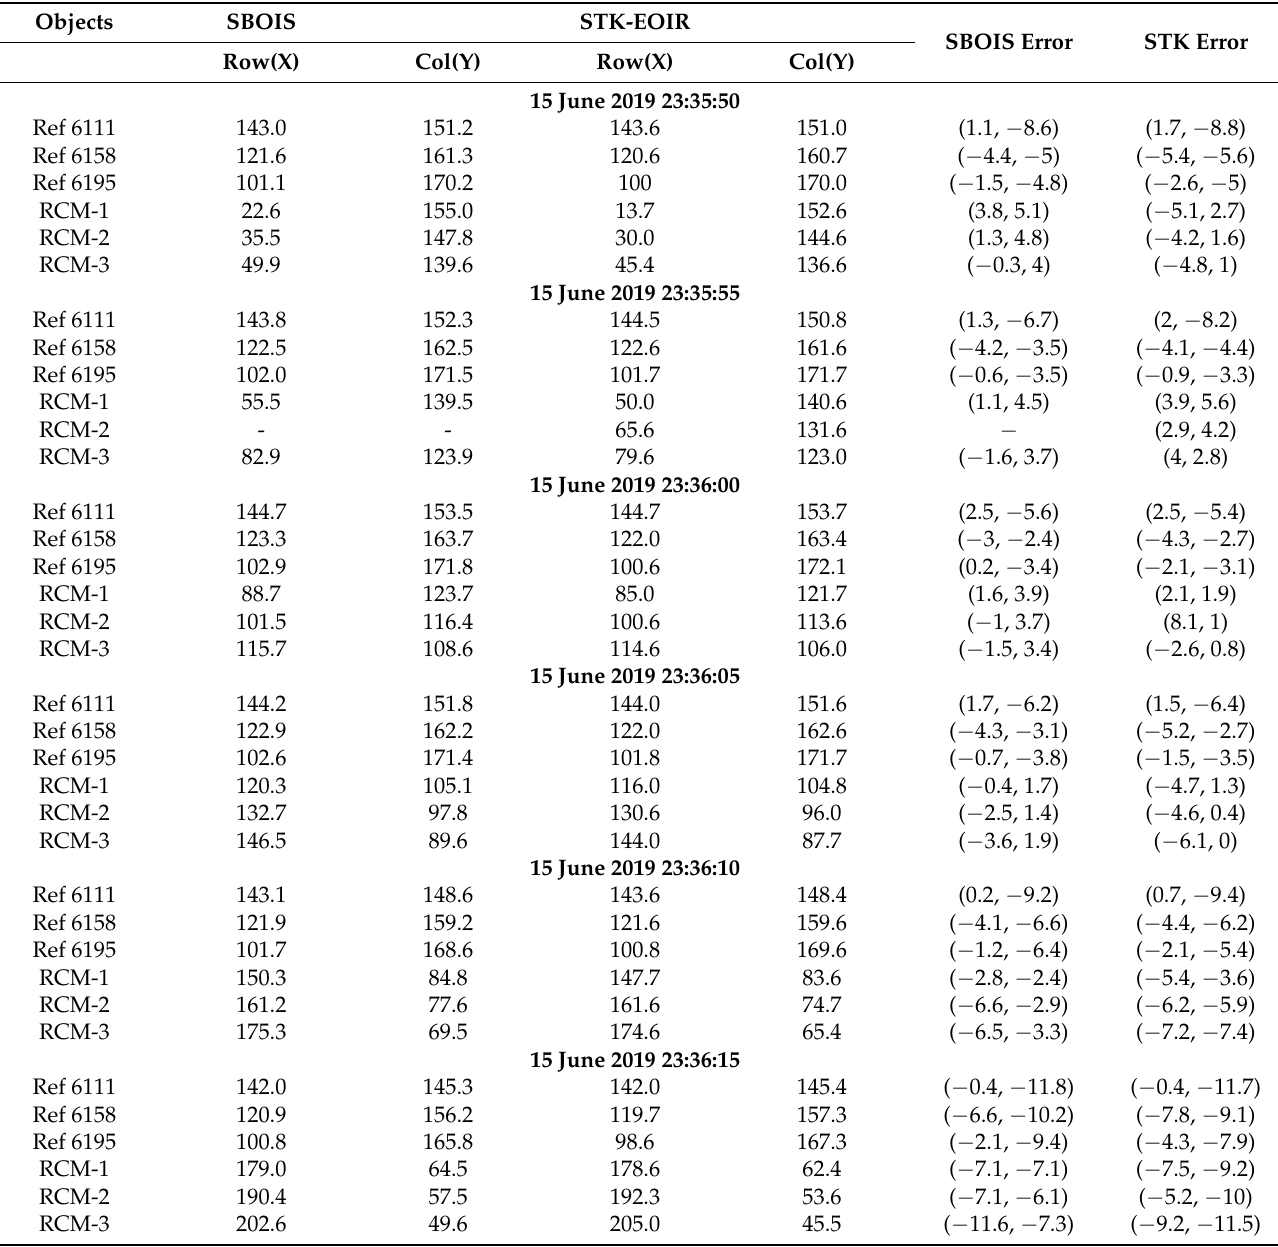
Table A1. Accuracy Analysis of Simulated Images Using SBOIS and